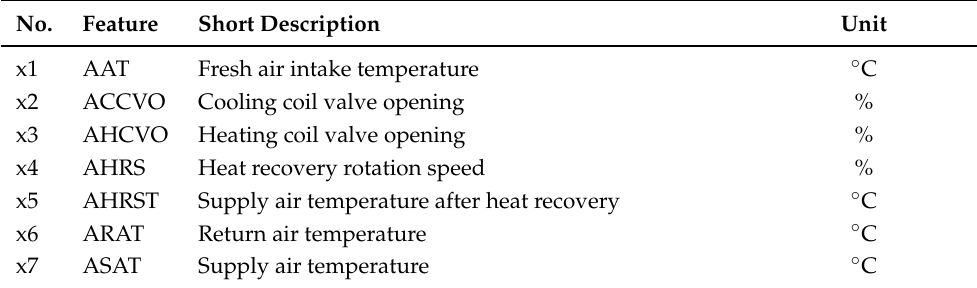
Table 2. Description of the used features in the AHU